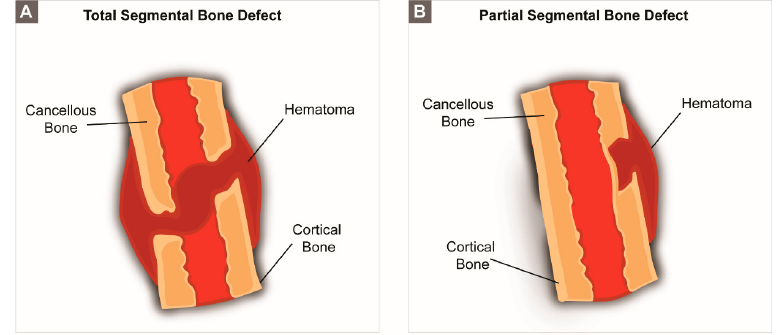
Figure 4. Schematic representation of ( A ) a full segmental bone defect and ( B ) a partial segmental bone defect.